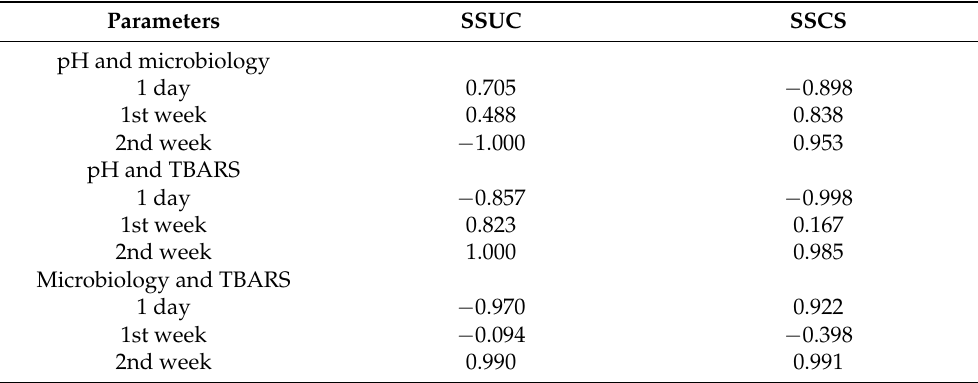
Table 5. Correlation between Longissimus dorsi muscle’s pH, microbiology, and oxidative stability (TBARS value) in Korean Hanwoo Finishing Cattle.